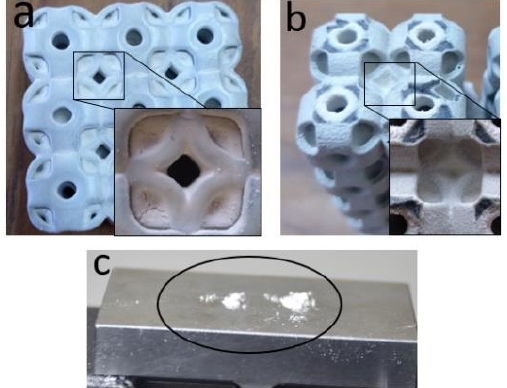
Figure 6. Performance of SU and OS structures with M and T at various stages under progressive compression — from left to the right side — (above), enlarged complete densification stage of each structure shown failure mechanism (below). ( a ) SU-M structure at 100% compression; ( b ) OS-M structure at 100% compression; ( c ) SU-T structure at 100% compression; ( d ) OS-T structure at 100%